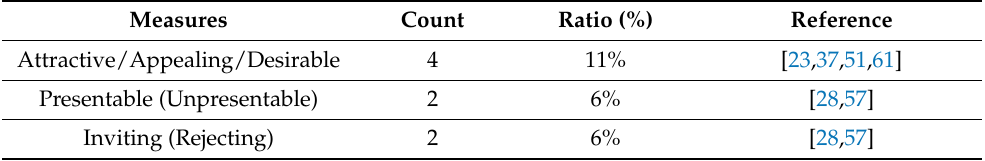
Table 6. Overall attractiveness of a